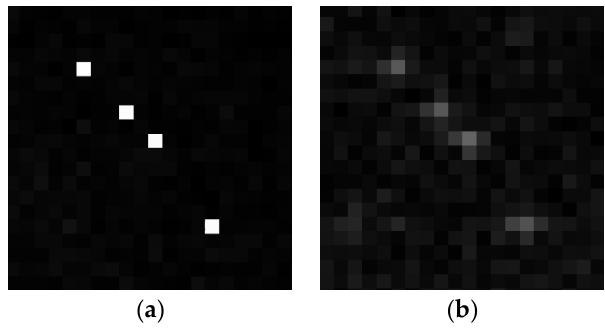
Figure 10. Magnitude coefficients before ( a ) and after ( b ) screen-cam.